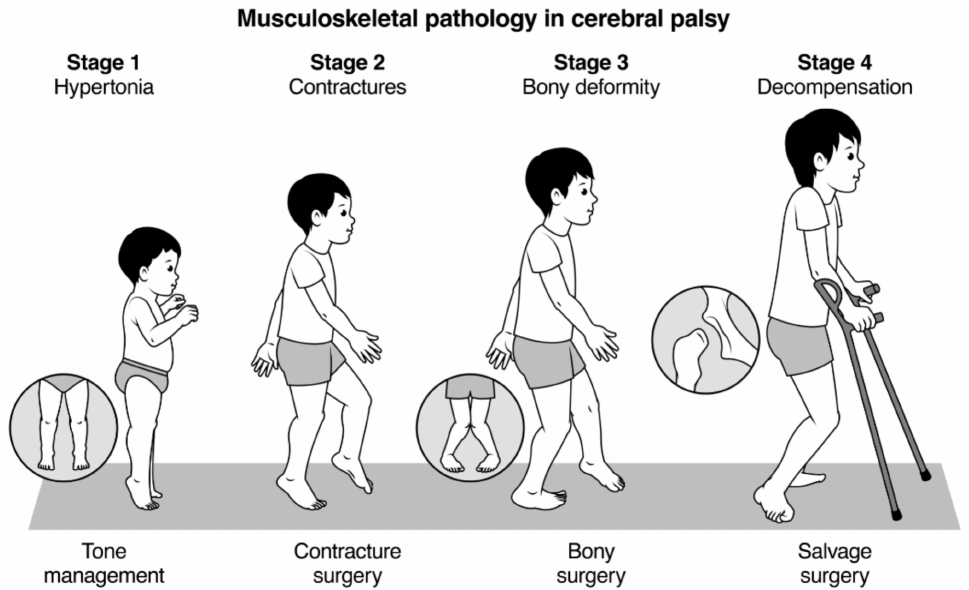
Figure 1. The stages of musculoskeletal pathology (MSP) in children with spastic cerebral palsy, from birth to skeletal maturity. Note the overlapping age ranges, and that features of Stage 2 and 3 usually occur